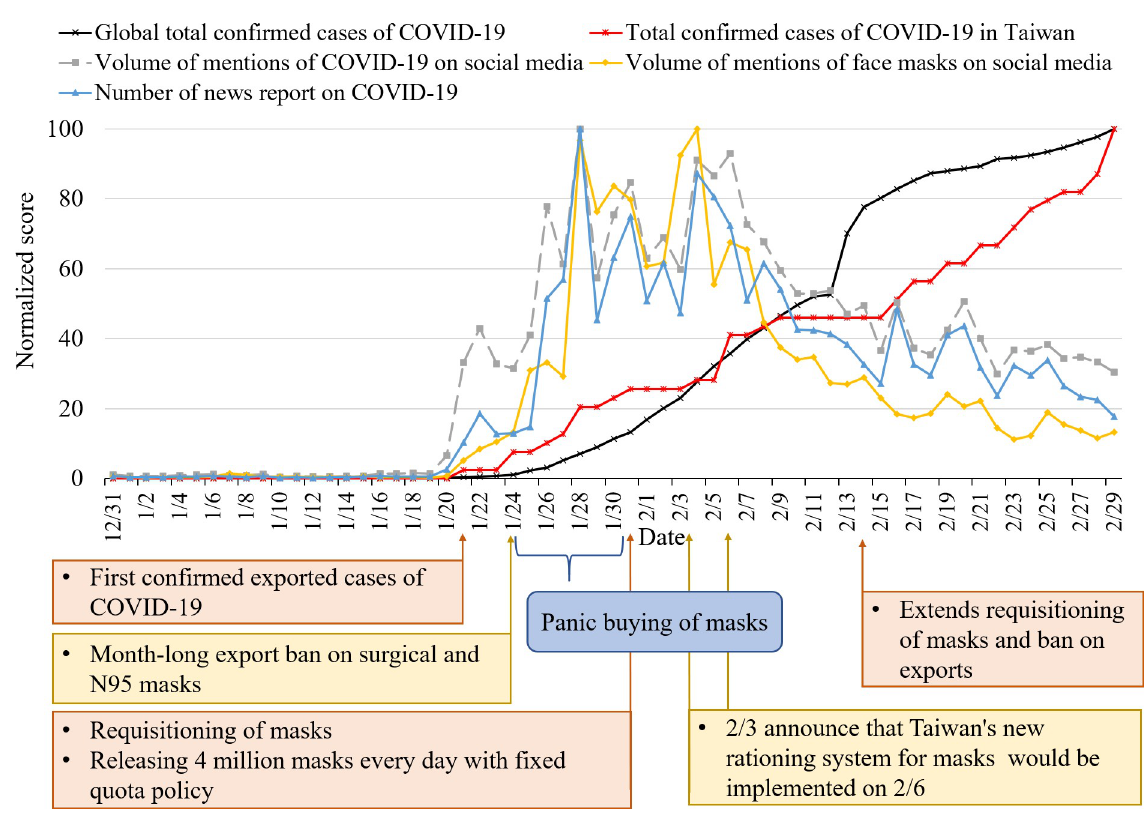
Fig 3. Trends of Google search volume for face masks in Taiwan, Singapore, Malaysia, Thailand, Vietnam, South Korea, and Japan.